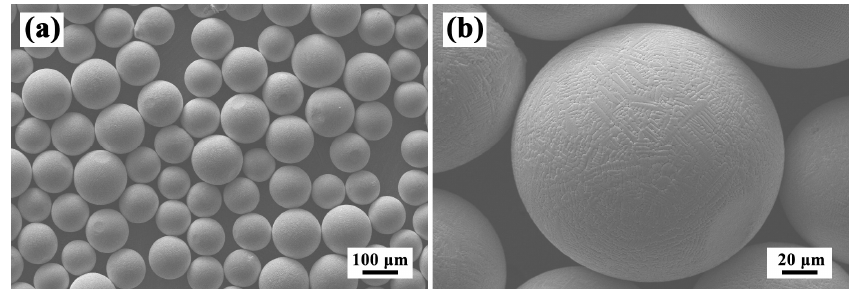
Figure 1. Morphologies of Inconel 625 powders at ( a ) low and ( b ) high magnifications. Table 1. The chemical compositions (wt %) of Inconel 625 alloy powder and substrate.